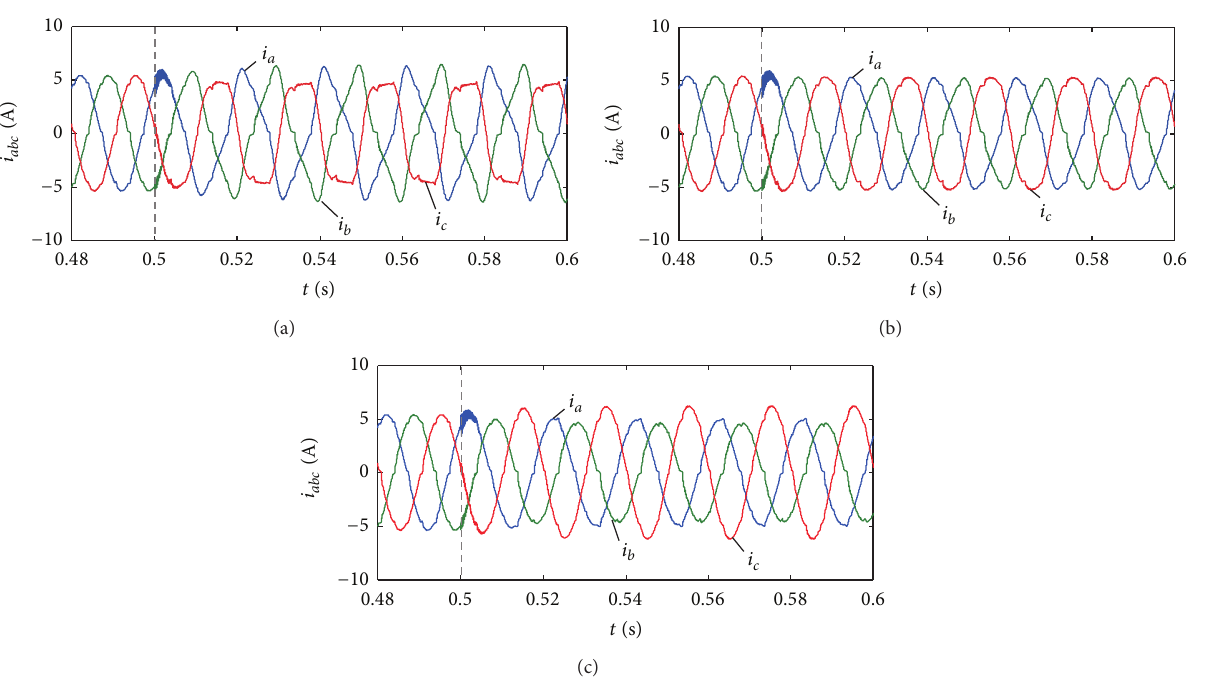
Figure 9: Output currents of photovoltaic generation for different 𝛽 coefficients. (a) 𝛽 = 1 , 𝑛 = 0.2 . (b) 𝛽 = 0.5 , 𝑛 = 0.2 . (c) 𝛽 = 0 , 𝑛 = 0.2 .